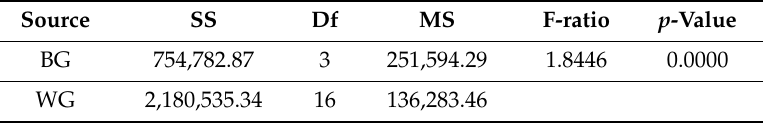
Table 3. ANOVA test for tensile modulus of five samples.